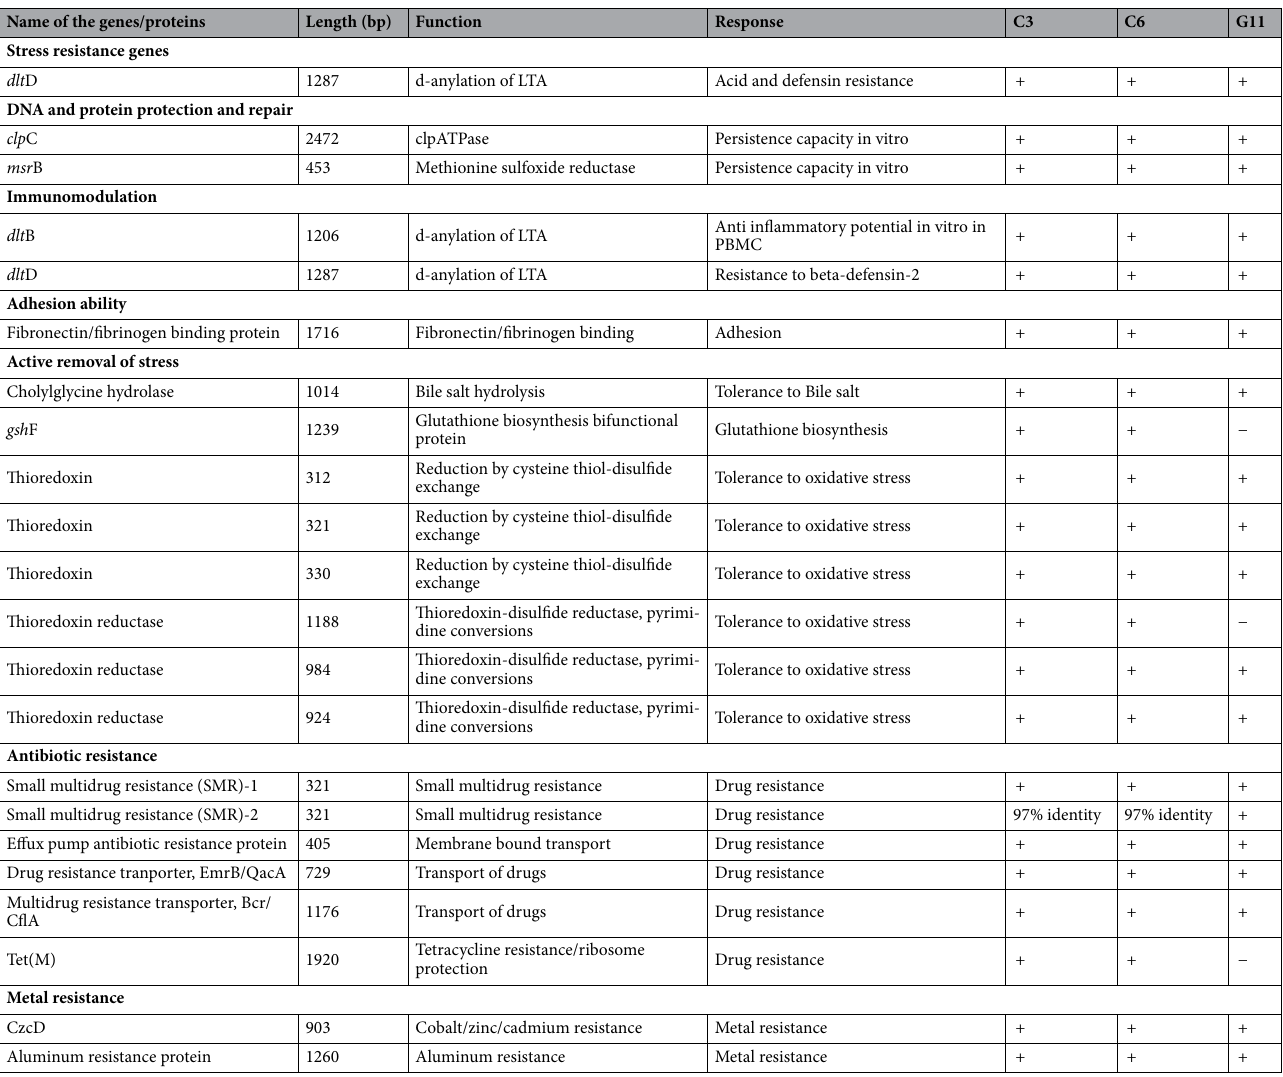
Table 2. Presence of genes/proteins related to probiotic activity in Pediococcus acidilactici